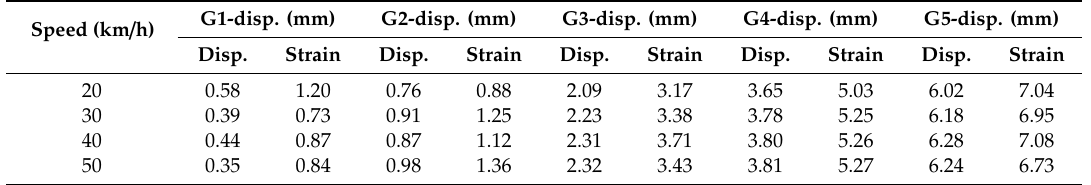
Table 4. Semi-static estimated and observed displacements for girders G1 to